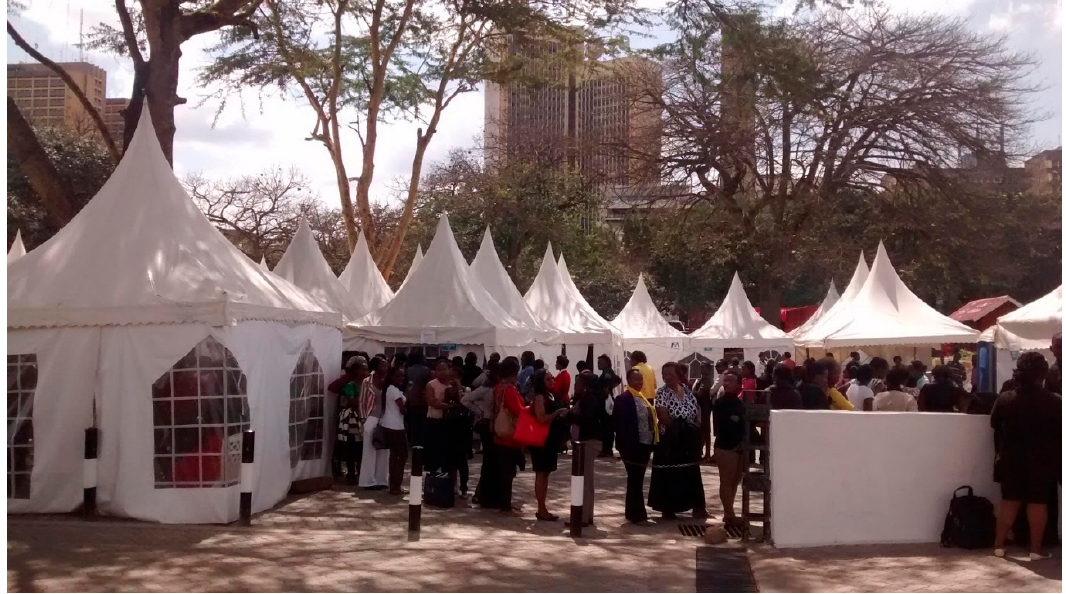
Figure 2. Screening camp at the 9th “Stop Cervical, Breast and Prostate Cancer in Africa“ (SCCA) conference offering free cervical cancer screening.